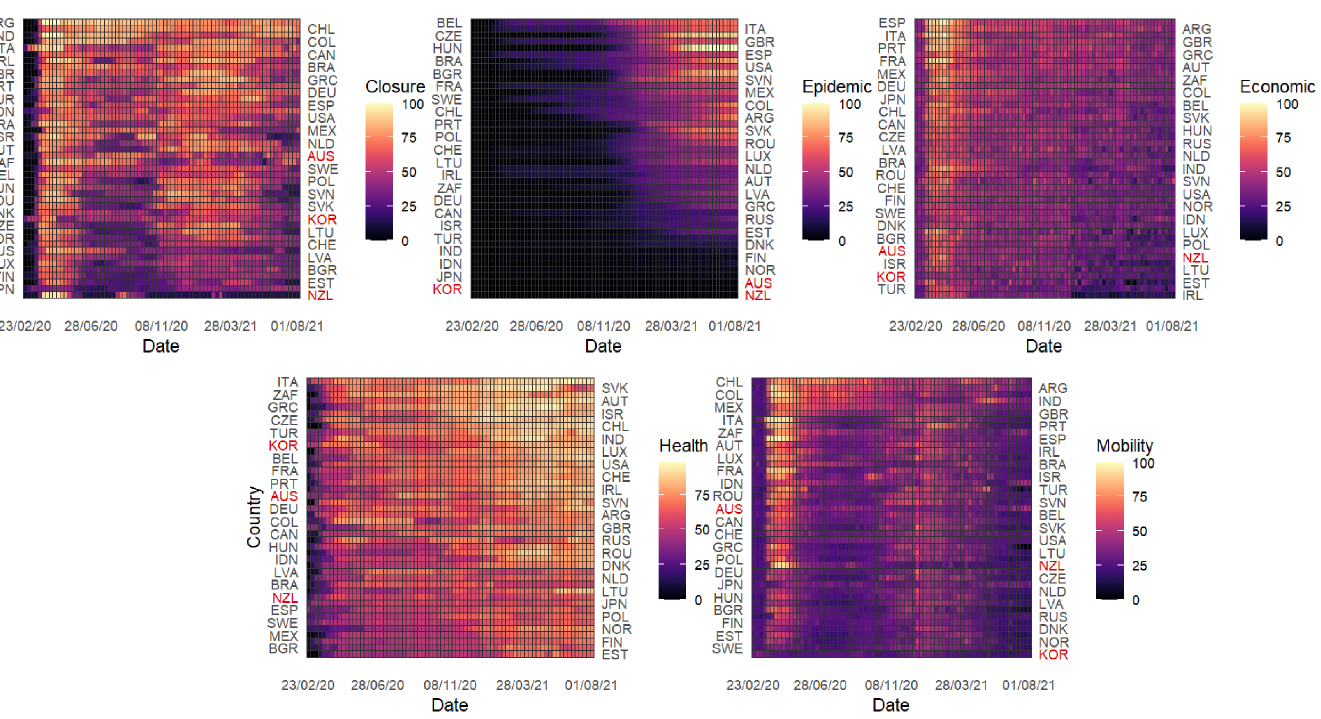
Fig 3. Indices considered to characterize the response of distinct countries to COVID-19. For all countries, the time course of the five indices is shown for the observational time between February 23, 2020 and August 01, 2021. Note that the country codes are reported on both sides of each heatmap to enhance the readability of the